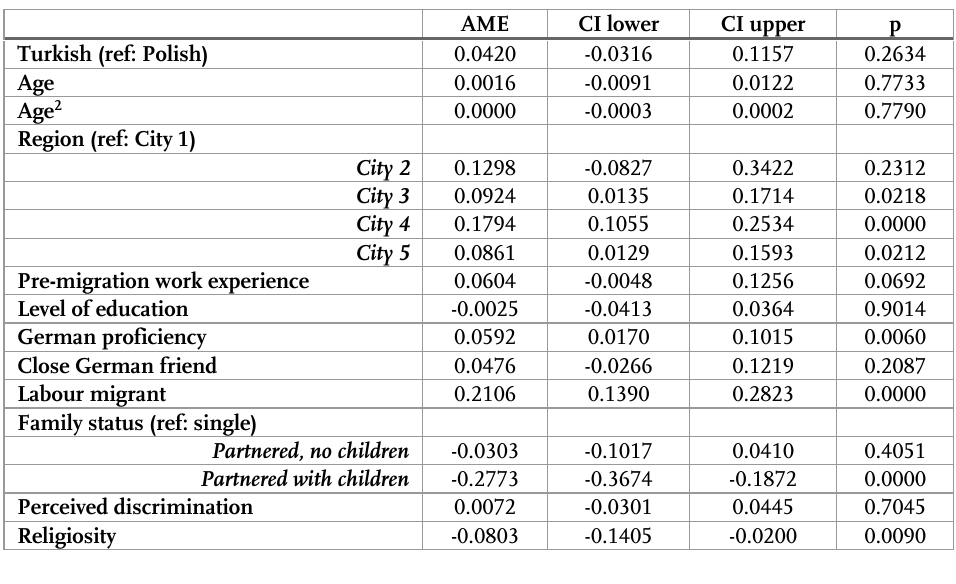
Table A.4 : Motivation model A (DV: Labour force participation)